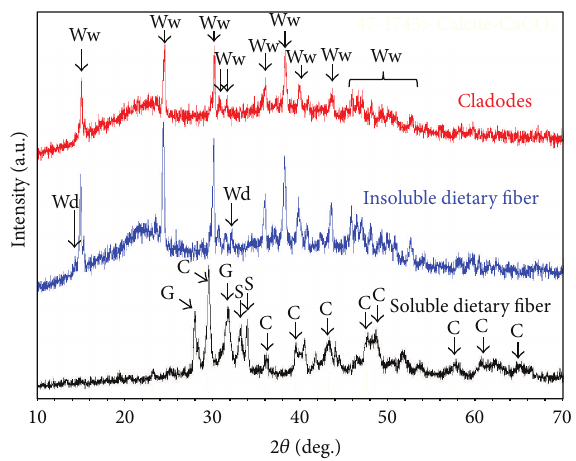
Figure 3: X-ray diffraction patterns of O. ficus indica samples (cladodes, insoluble, and soluble dietary fiber). Ww: whewellite; Wd: weddellite; C: calcite; G: glauberite; S: